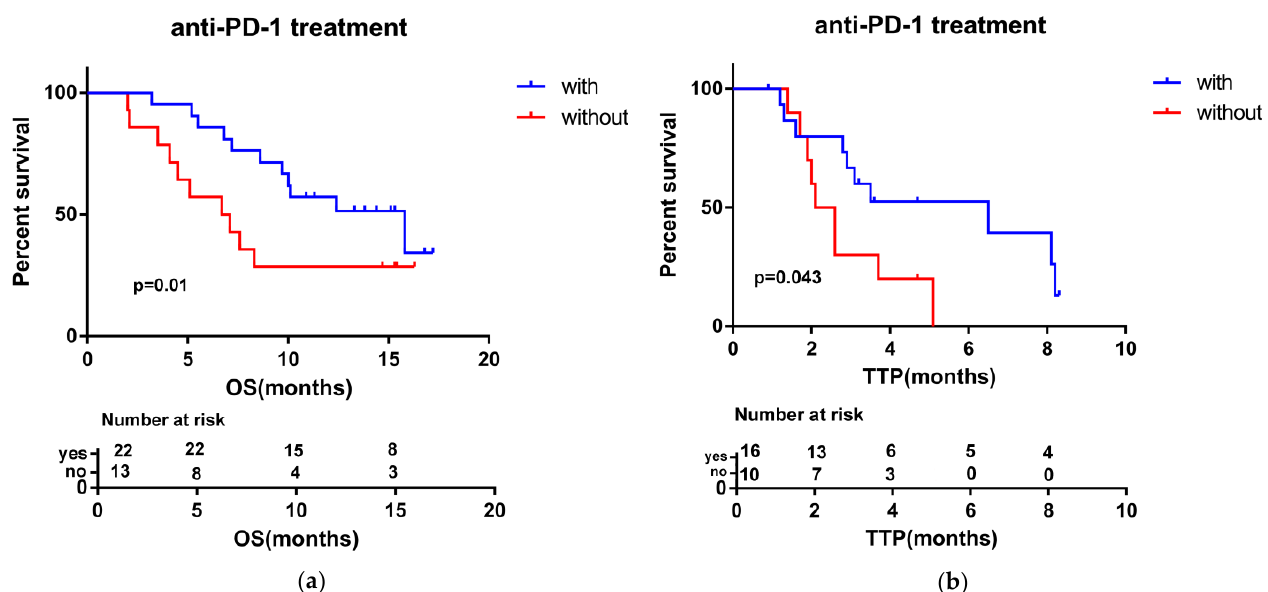
Figure 2. Kaplan – Meier curves for overall survival (OS) ( a ) and TTP ( b ) for patients with clinical benefits (CR + PR + SD) and without clinical benefits (PD) in HCC patients treated with HAICROX, who experienced TACE treatment failure or unsuitability.